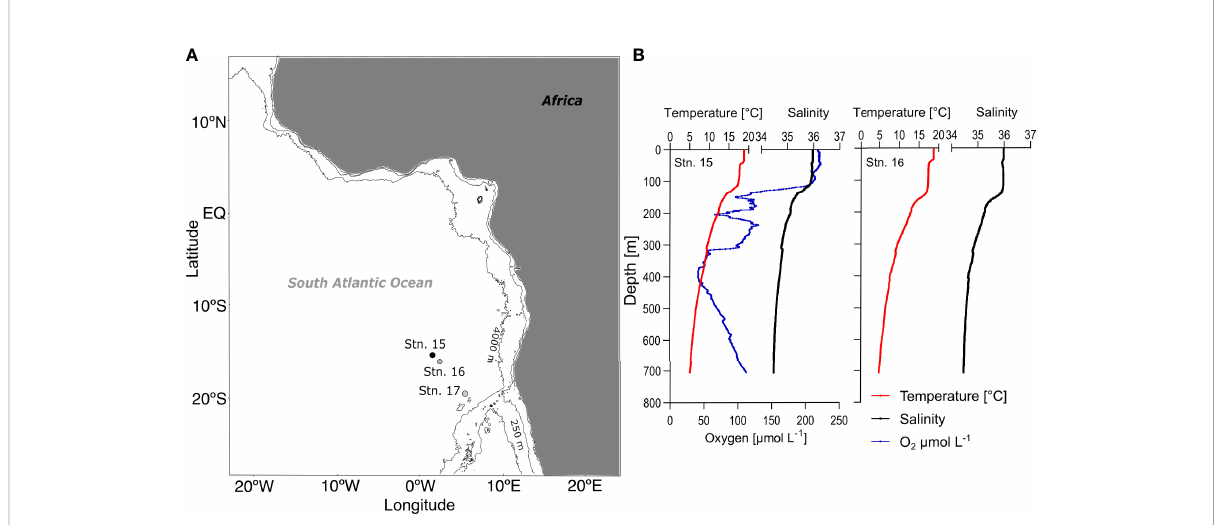
FIGURE 1 Study area and physical parameters. (A) Day (stn. 16, grey dot) and night (stn. 15, black dot) stations located in the southeastern subtropical Atlantic; (B) Temperature (°C, red), salinity (black) and dissolved oxygen (µmol L -1 , blue, only stn. 15) for day (left) and night (right) from surface to 700 m depth. Stn. 17 (open circle) was added for primary production reference